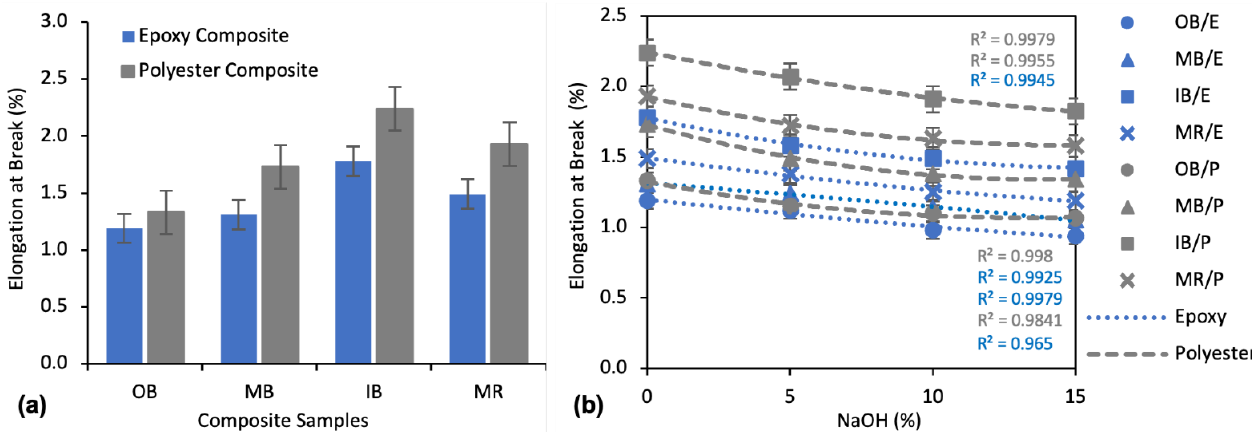
Figure 11. ( a ) Eb% of untreated (0% NaOH) composites; ( b ) Effect of alkali treatment on Eb% of the composites. The effects of NaOH on the Eb% of the composites are illustrated in Figure 11b. Alkali treatment reduced the Eb% to a small extent. A maximum reduction of 21.0%, 19.8%, 20.2%, and 20.1% Eb% was found for OB/E, MB/E, IB/E, and MR/E composites, and 19.9%, 22.5%, 18.5%, and 18.1% for OB/P, MB/P, IB/P, and MR/P composites, respectively, at a concentration of 15% NaOH.